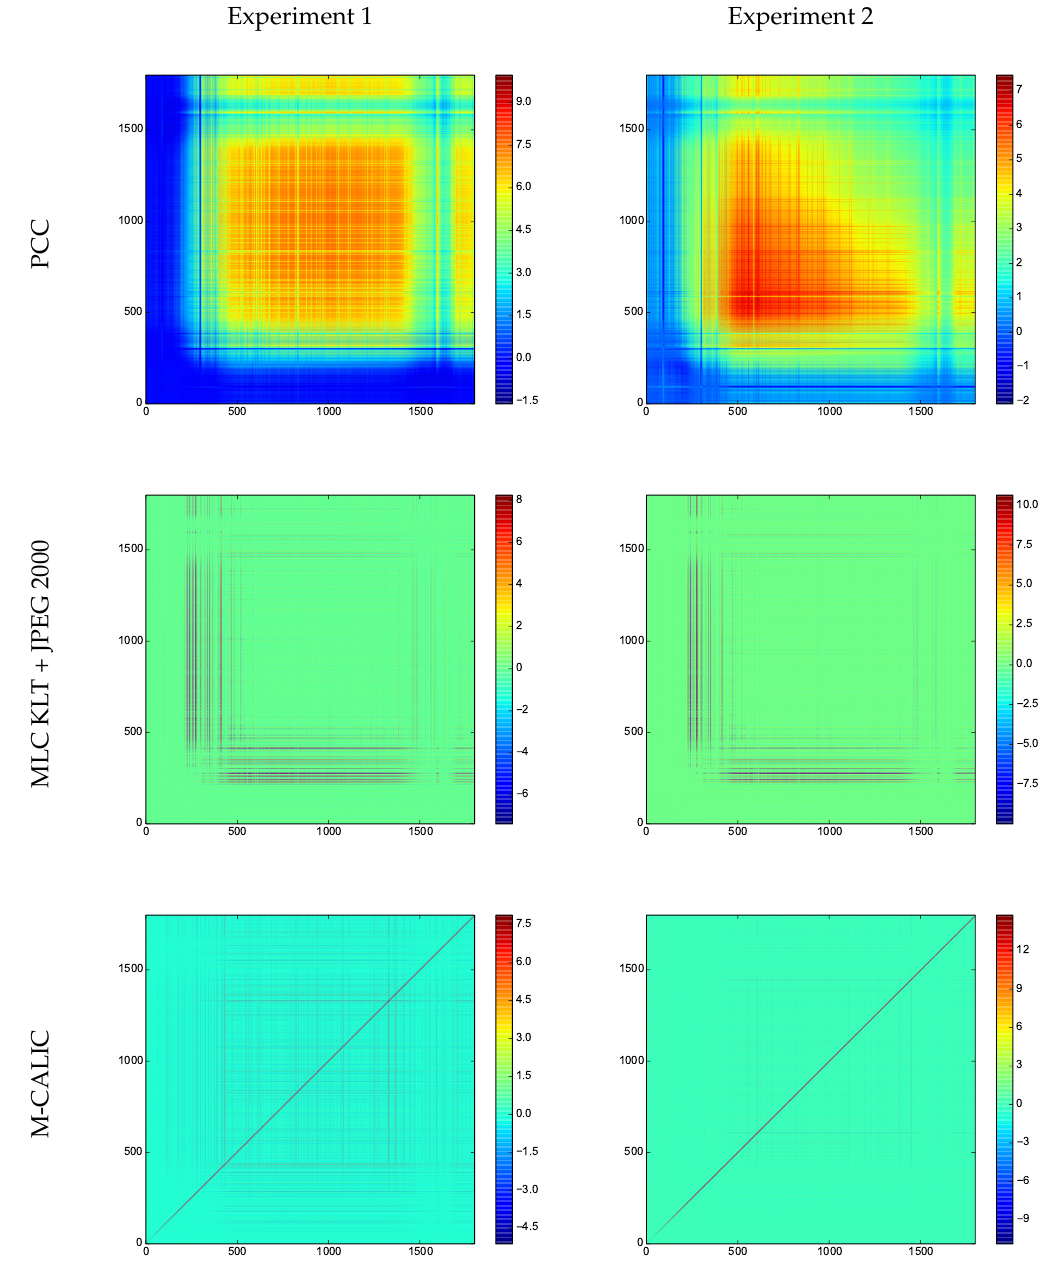
Figure 17. Differences between the covariance matrix of the original radiances and the covariance matrix of the reconstructed